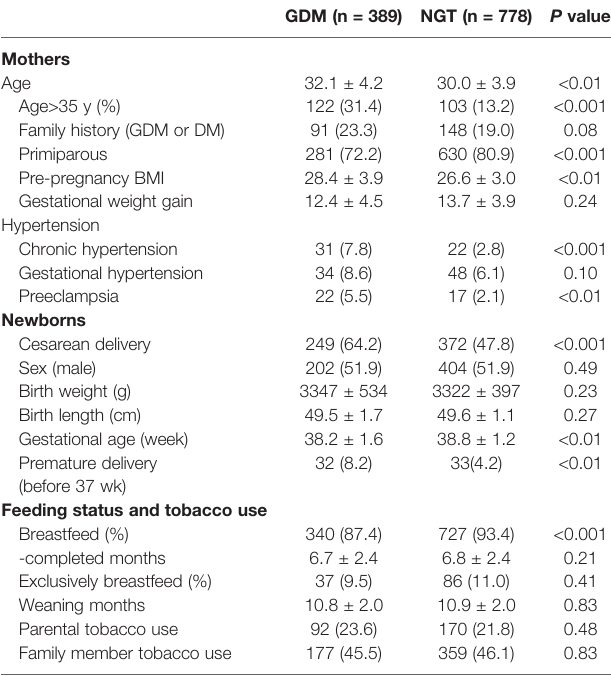
TABLE 1 | Characteristics of the mothers and their offspring between normal glucose tolerance and GDM.